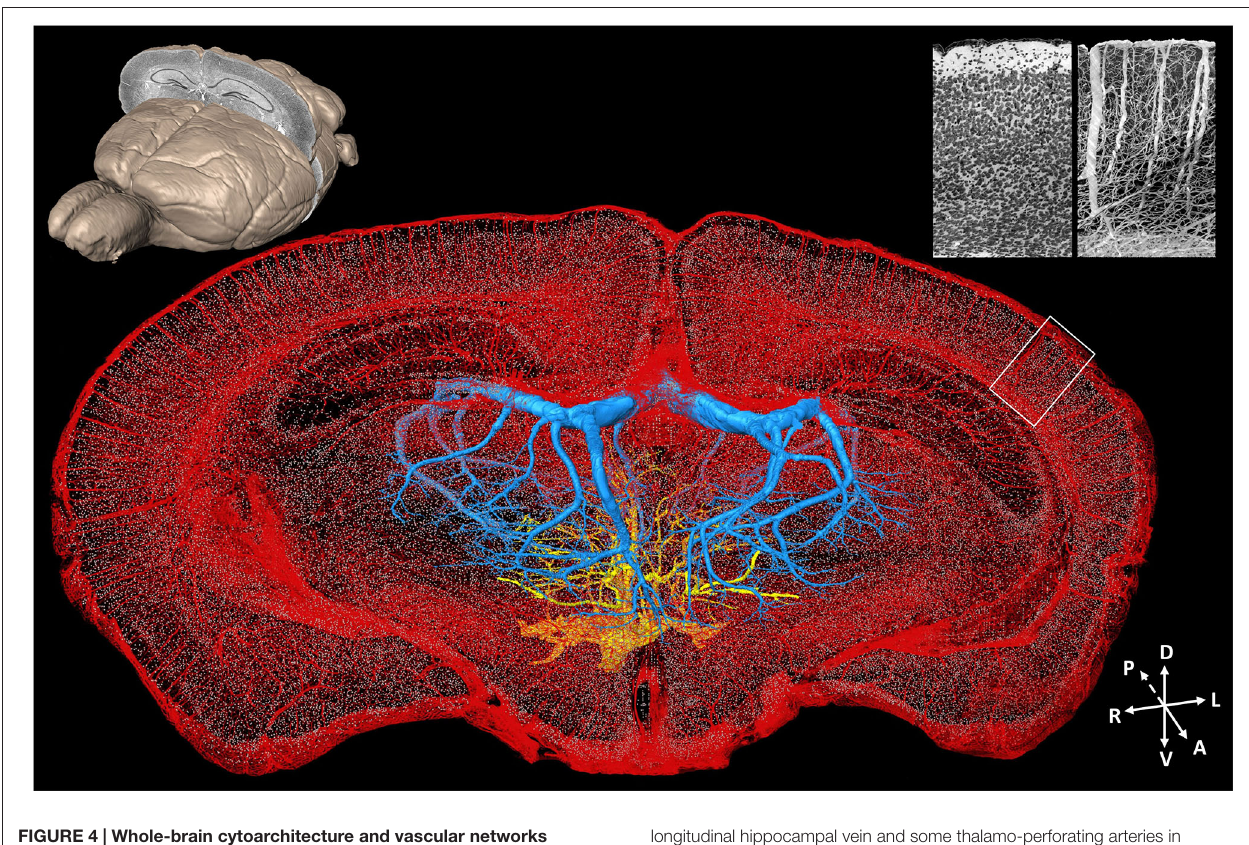
FIGURE 4 | Whole-brain cytoarchitecture and vascular networks acquired by the MOST method . A 3D reconstruction of the mouse brain is in the top left corner; the selected 300 µ m slab at the coronal plane presents the spatial location of the data at the center. The center shows the cytoarchitecture and vascular network, simultaneously acquired in the brain. Blue and yellow represents the branches of the